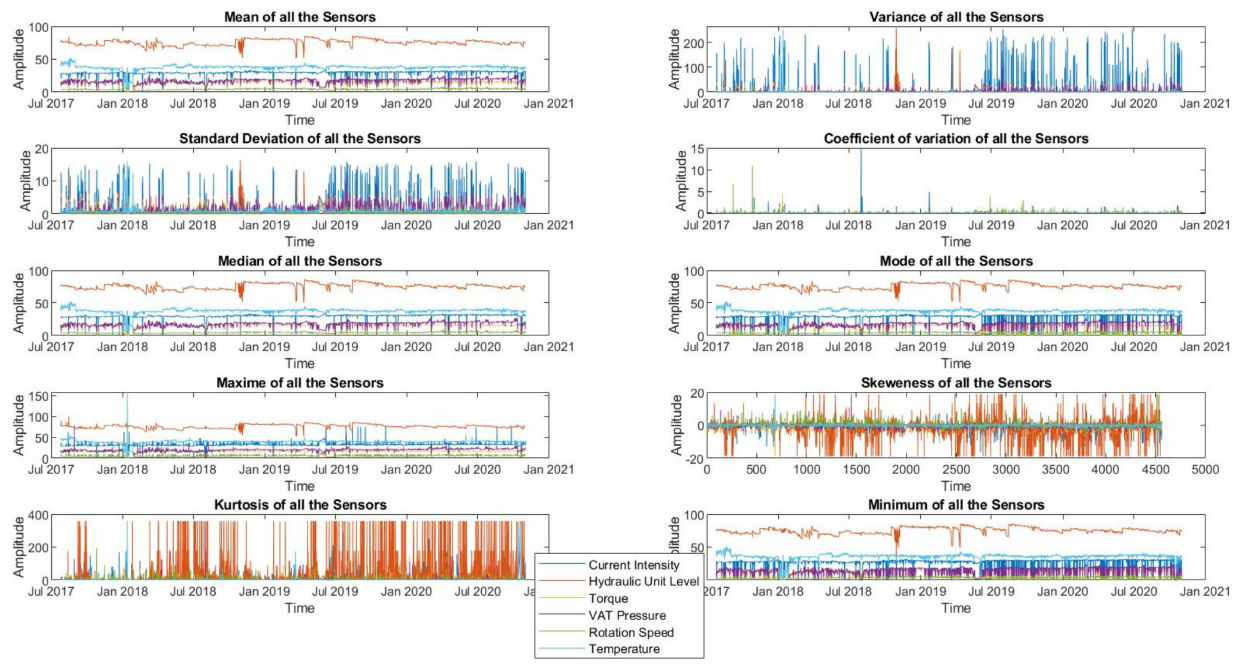
Figure 3. All features for each one of the signals sensors.